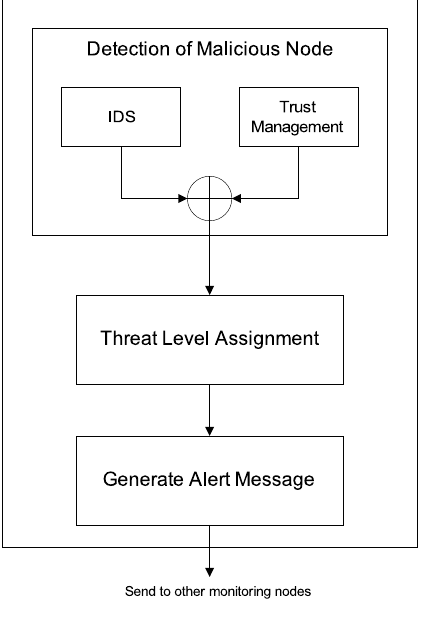
Figure 3. Intrusion-aware validation algorithm at sender